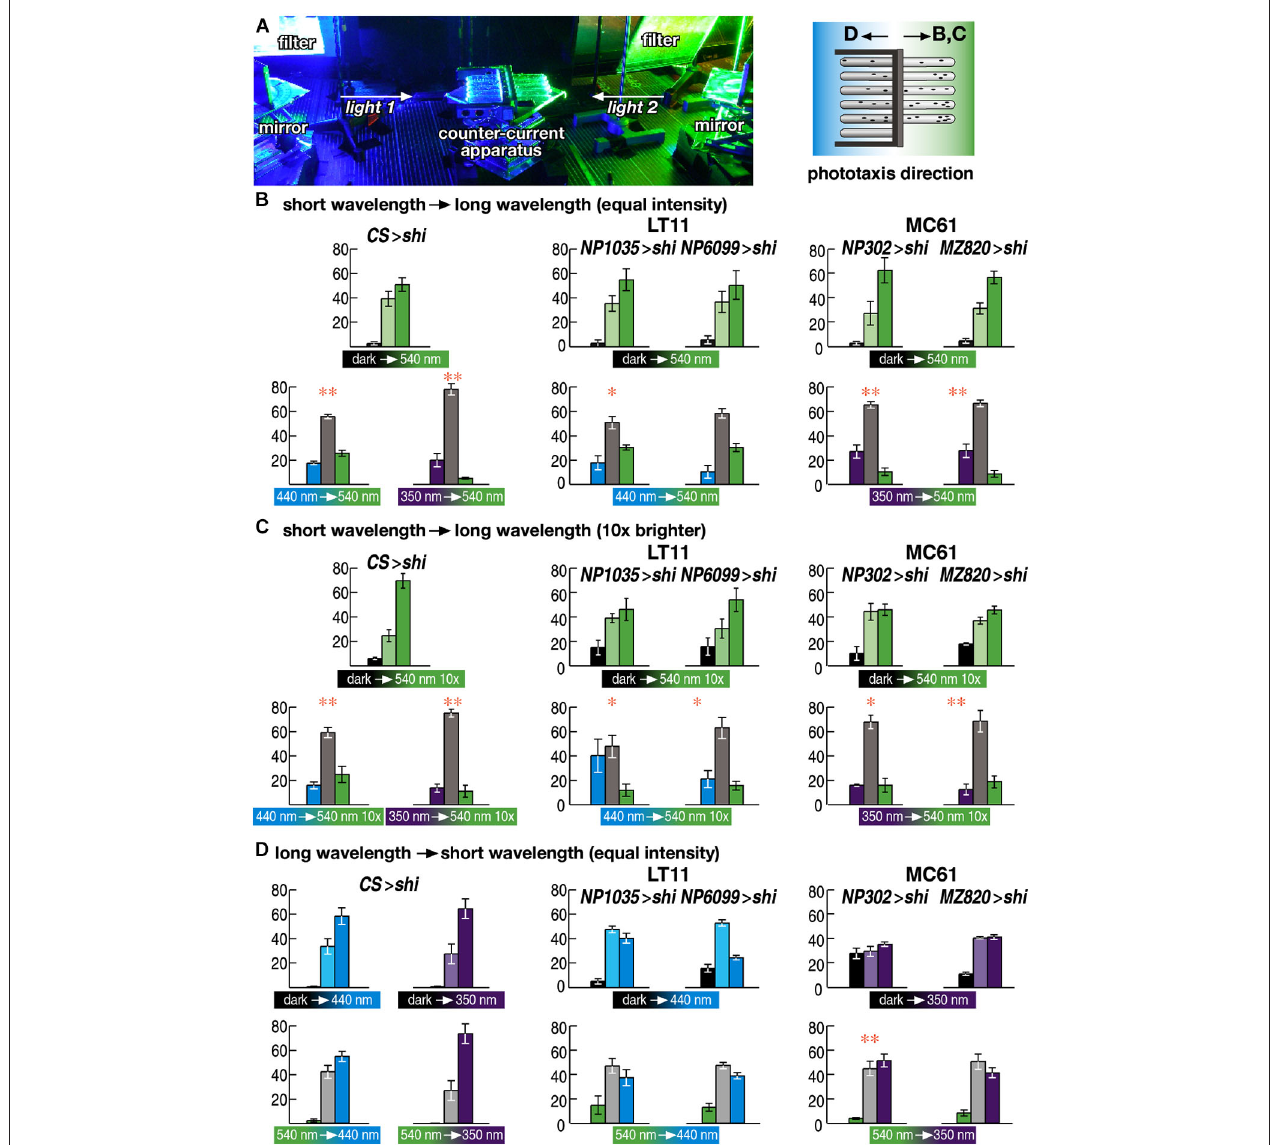
350 nm for LT11 and MC61, respectively). Light intensity was adjusted to the same level as in Figure 3 (3 × 10 18 p/m 2 s) in (B, D) but was set to 10 times brighter (3 × 10 19 p/m 2 s) in (D) . Mean ± SEM of three independent measurements. Statistical significance of the differences between phototaxis (above) and choice assay (below) are indicated with ** ( p < 0.01), * ( p < 0.05; t